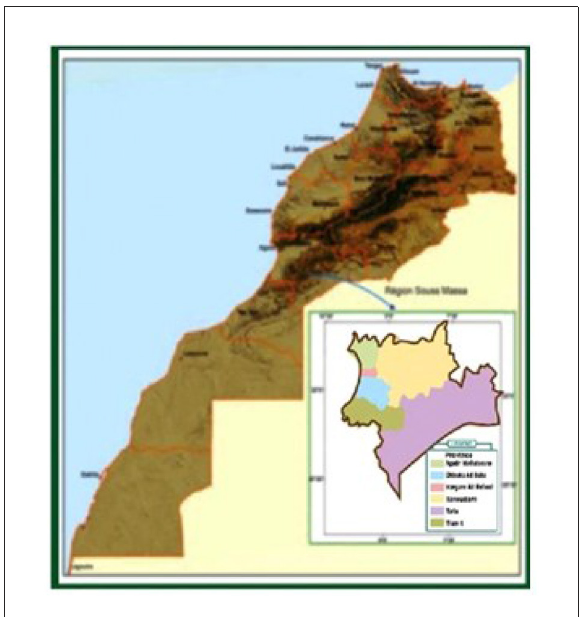
FIGURE2 Map showing the Souss Massa region and its